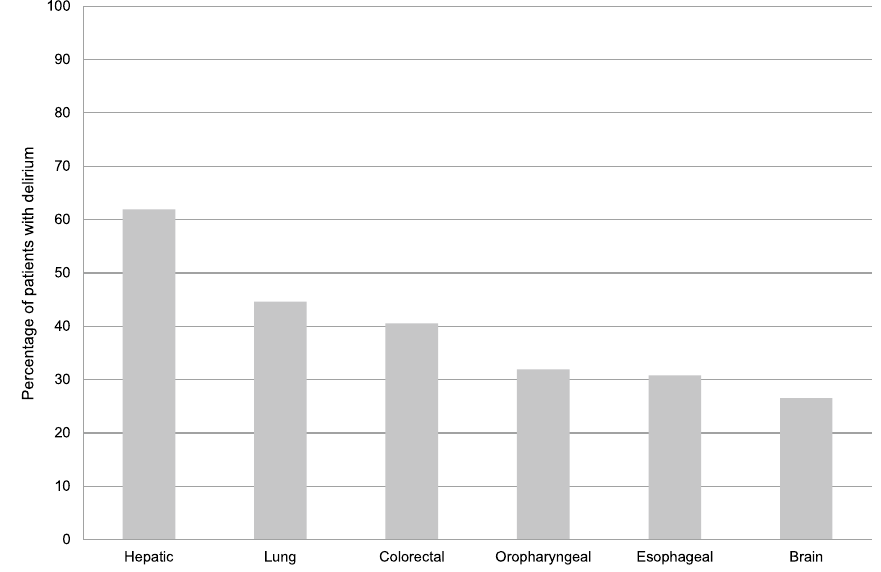
Figure 2. Percentage ICU patients with malignancy who developed ICU delirium stratified by malignancy type. ICU intensive care unit.